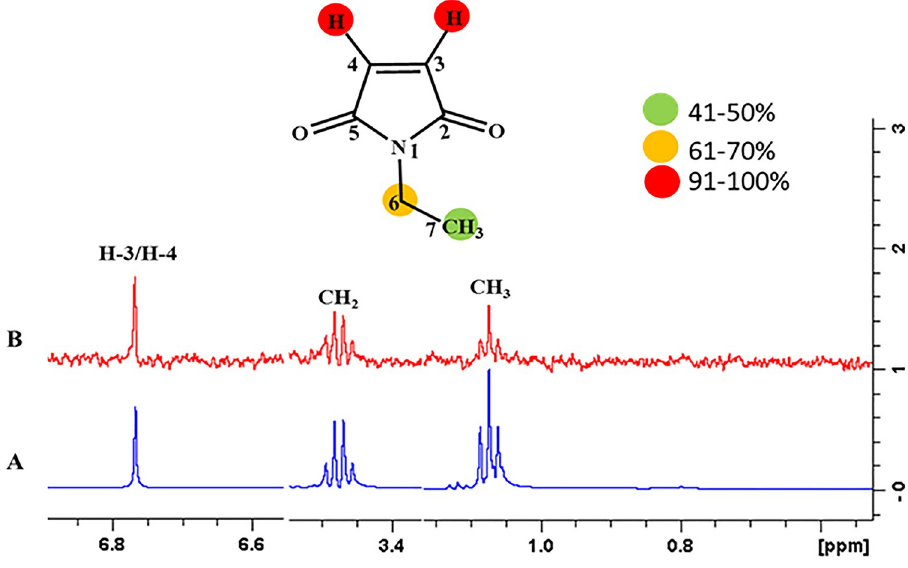
Fig 15. (A ) Reference 1 H-NMR spectrum of standard inhibitor N -Ethylmaleimide. (B) Difference spectrum of N - Ethylmaleimide with the enzyme.